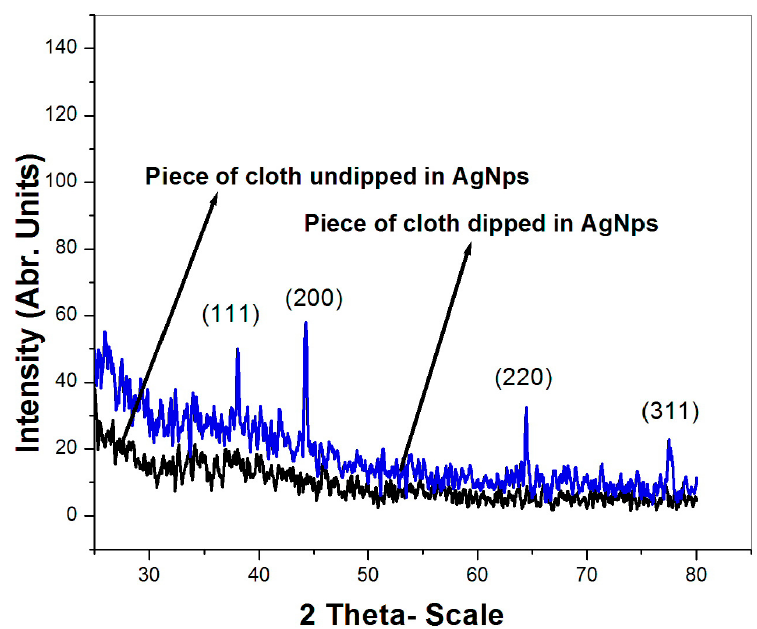
Figure 6. X-ray diffraction of a pieces of cloth dipped into a colloids solution AgNPs (blue line), and a pieces of cloth not dipped into a colloids solution AgNPs (black line).